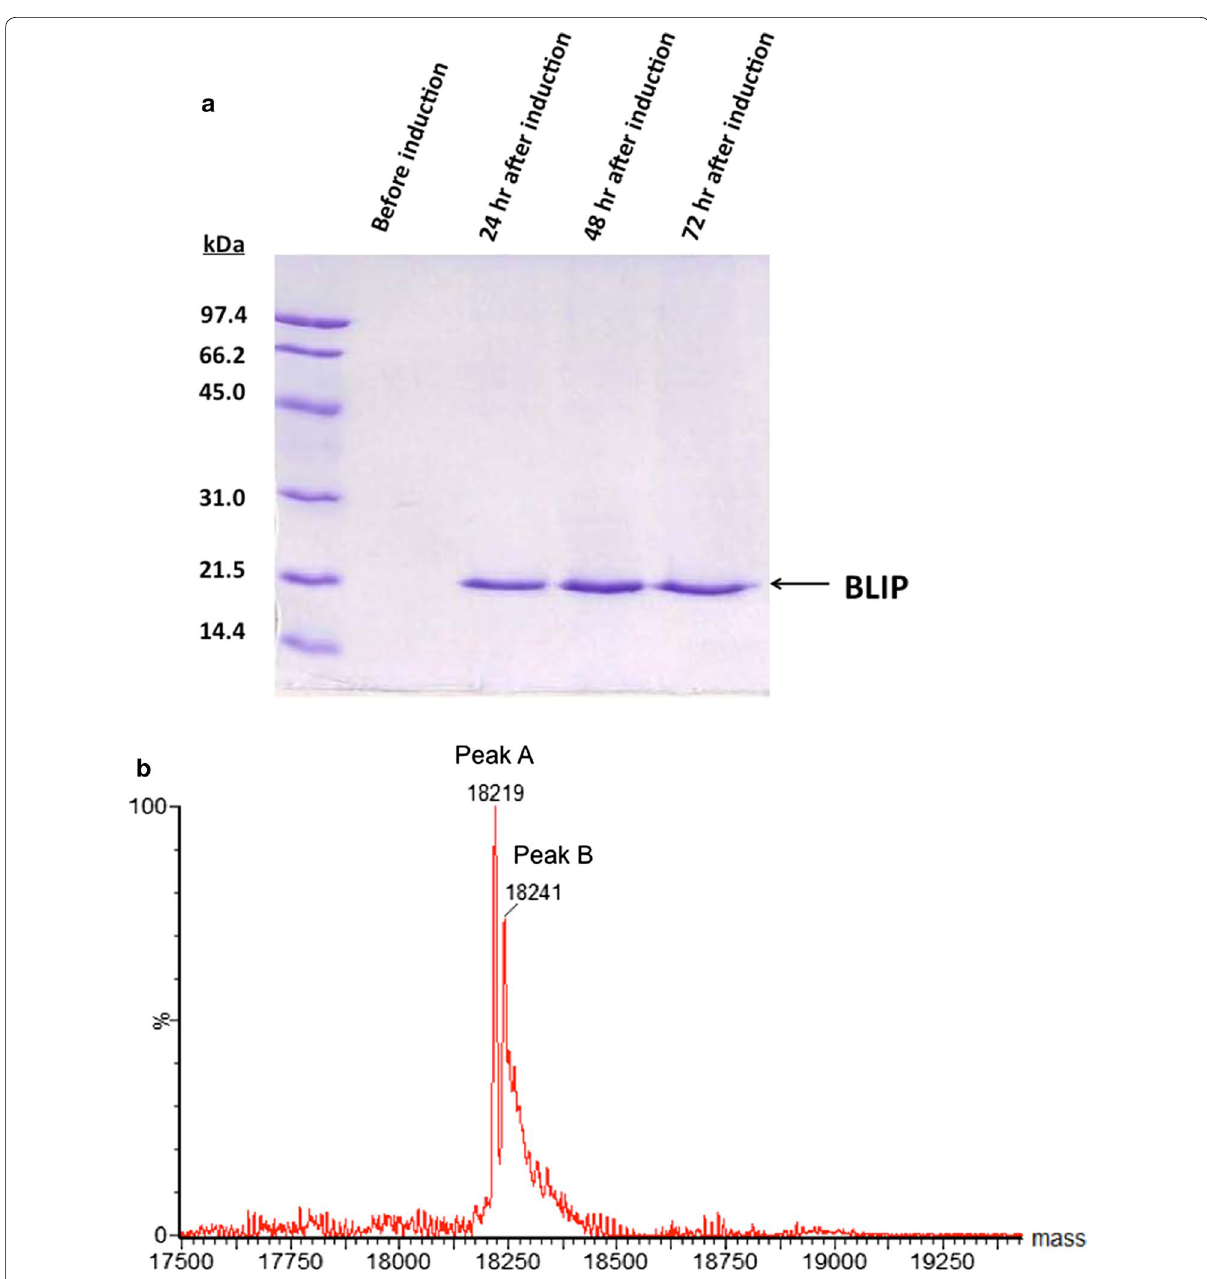
Fig. 3 Expression of secretory BLIP in P. pastoris . a As revealed by a coomassie‑blue stained SDS‑PAGE gel, highly pure BLIP was found to be present in the culture media collected 24, 48 and 72 h after induction with 2% MeOH. b As analyzed by ESI–MS, the measured mass of the secretory BLIP (peak A) was 18,219 which matched the calculated mass of EAEAEF‑mature BLIP (18,219.25). Peak B with molecular mass of 18,241 corresponded to the sodium adduct of the secretory